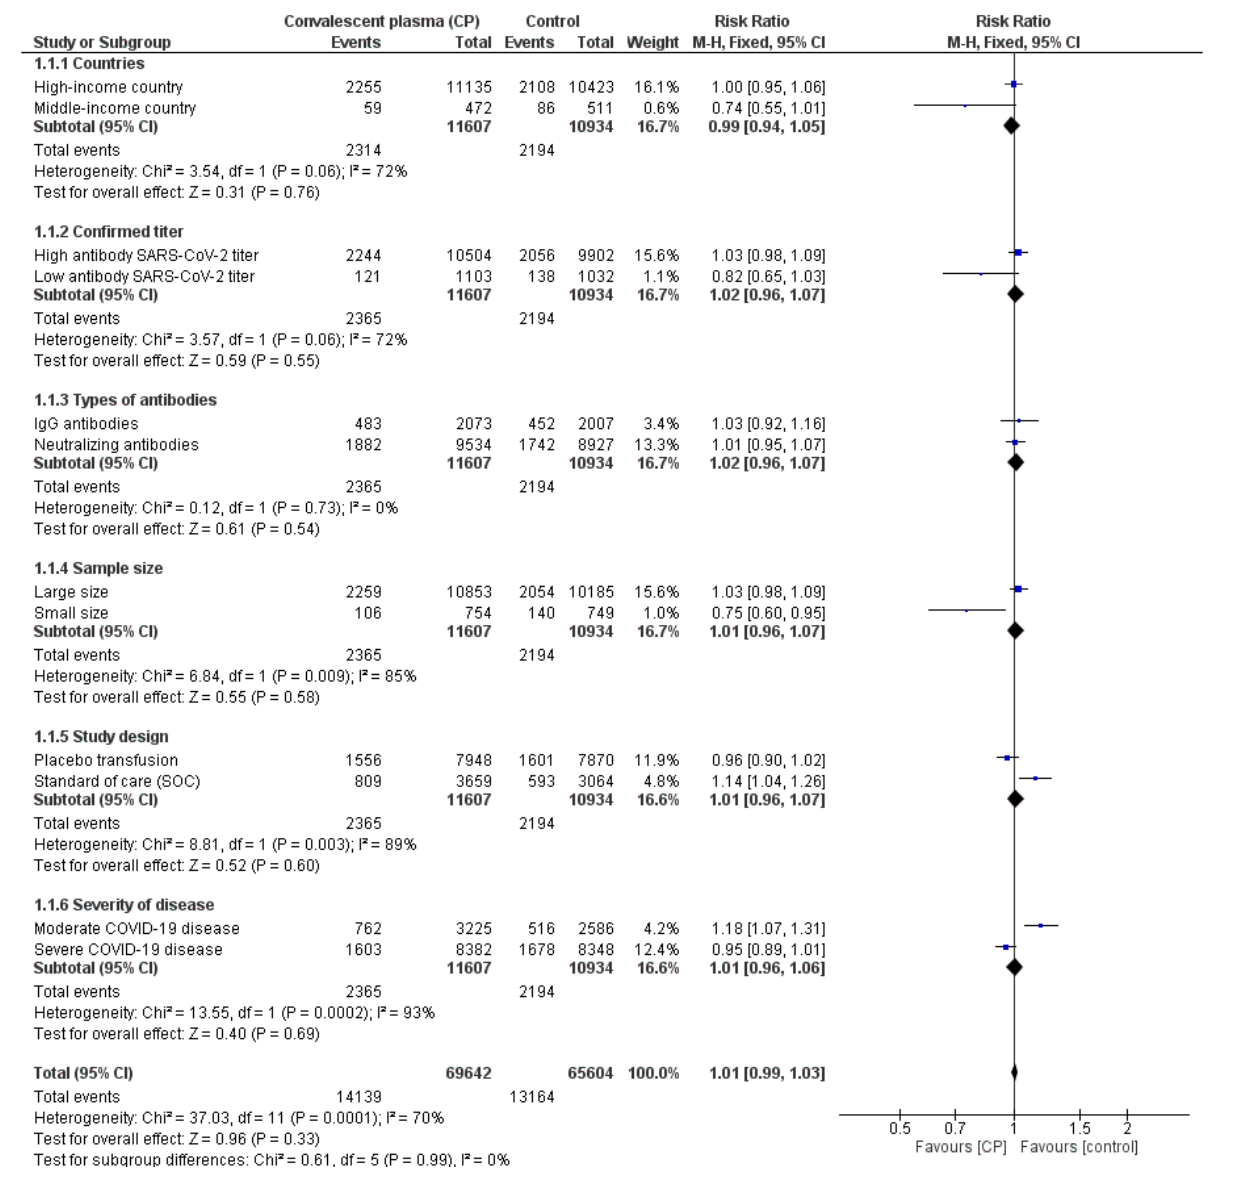
Figure 5. Subgroup analysis for mortality reduction based on six sub-criteria: country, confirmed titer, types of antibodies, sample size, study design, and severity of disease.